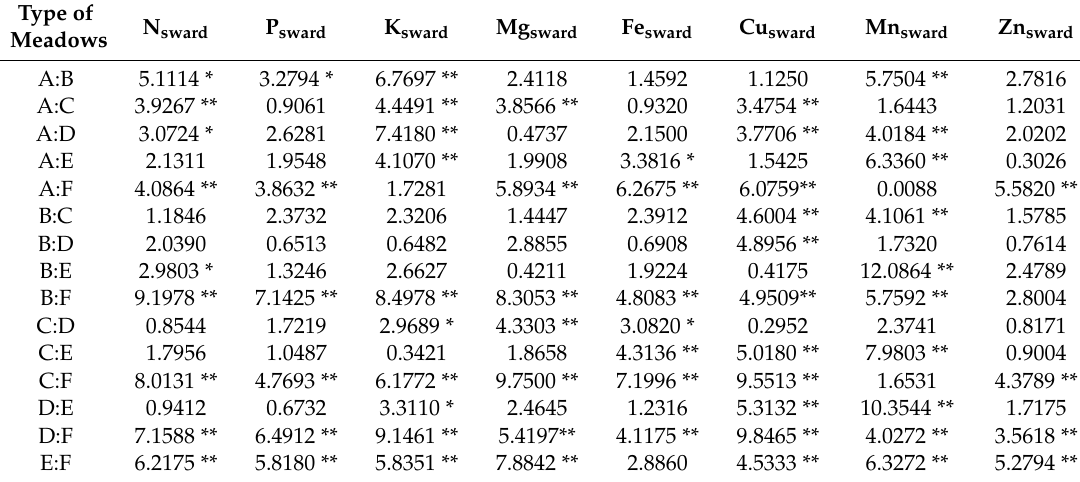
Table 5. Post-hoc test results (Dunn test–Z